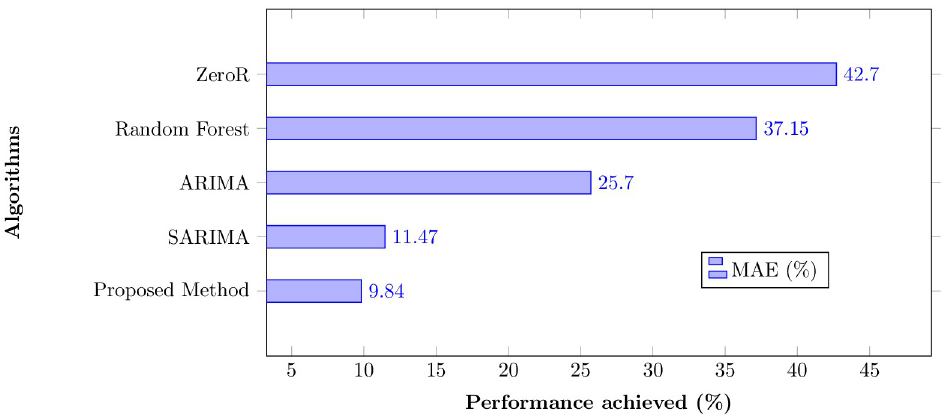
Fig 10. Comparison of the proposed approach with state-of-the-art